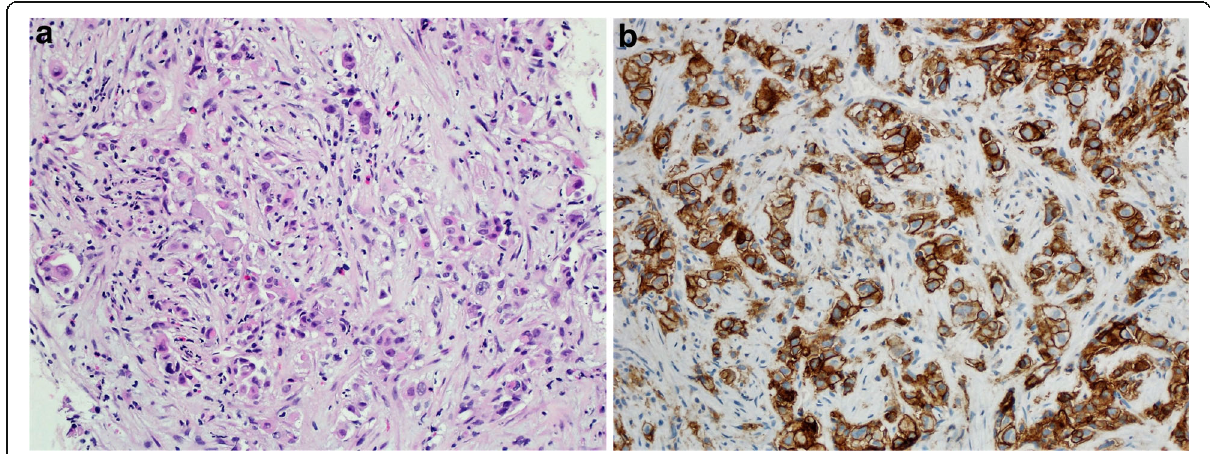
Fig. 11 A Case of metastatic pulmonary adenocarcinoma to the liver. B Immunohistochemical staining for tumor cells, moderate to intense